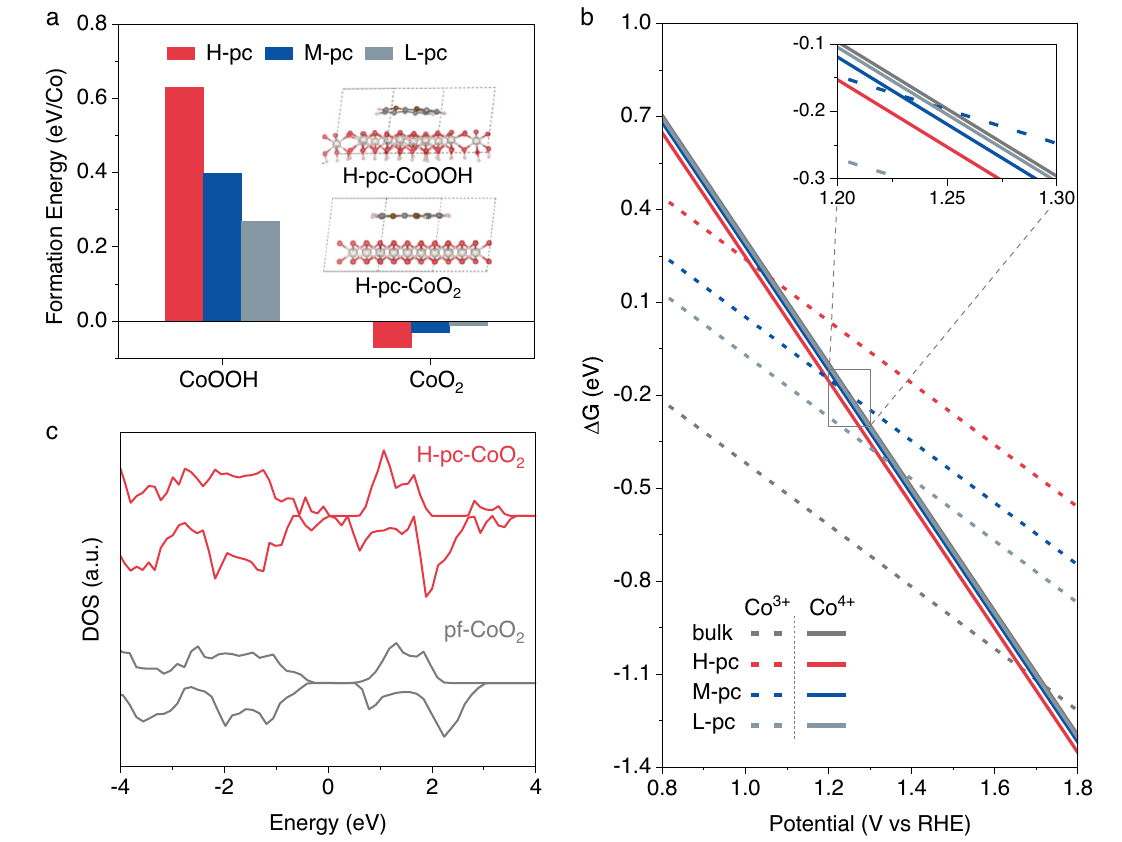
Fig. 3 | DFT calculations. a The formation energy of layered CoOOH and CoO 2 containinghigh(H)-,middle(M)-,andlow(L)-densityofphen(i.e.,1,0.5,and0.33ML phen) in the interlayers. Inset shows the models of high-density of phen inserted into layered CoOOH and CoO 2 . Metal Co and C, N, O, and H are represented by